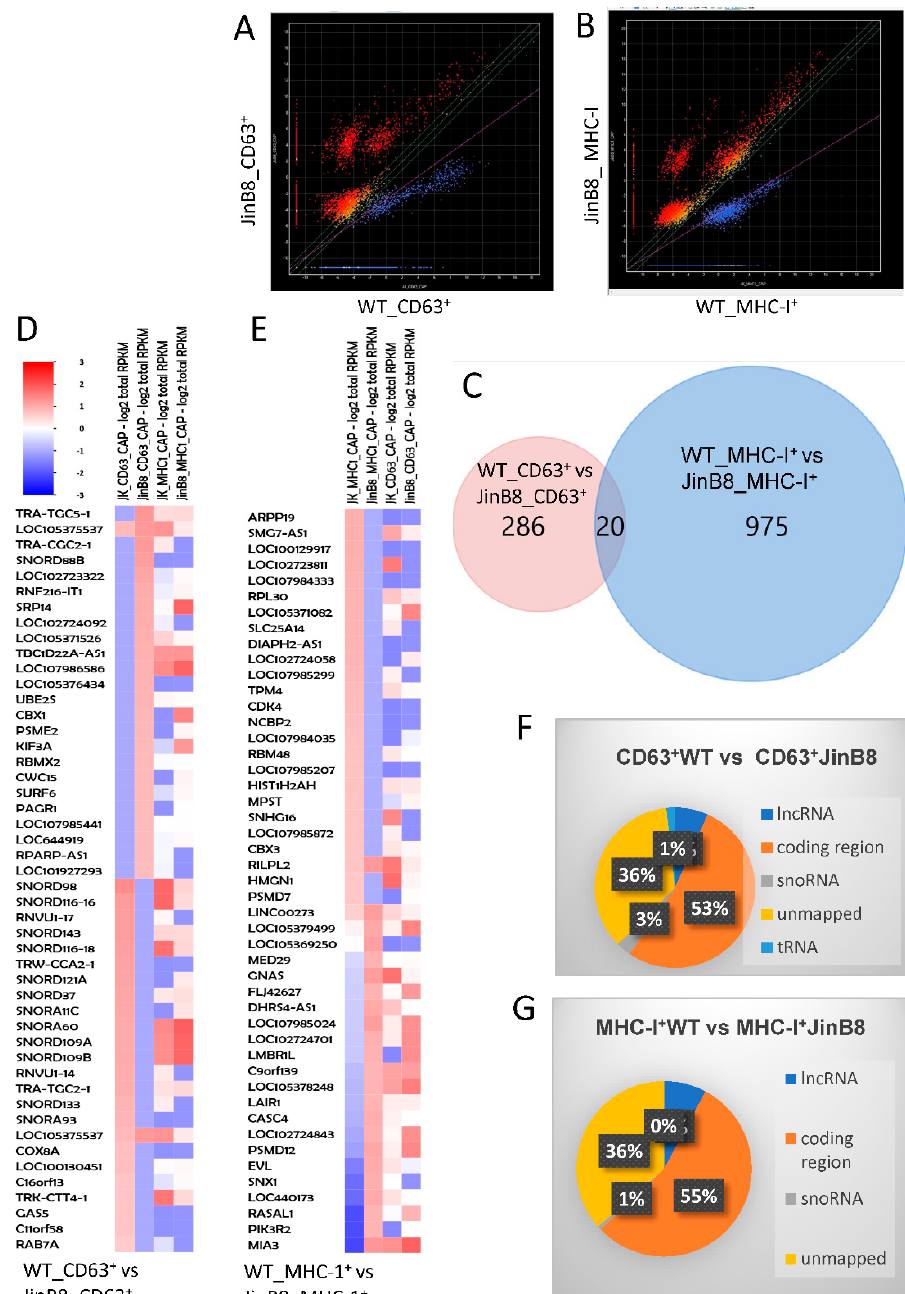
Figure 2. ( A ) Scatter graph showing abundance of RNAs in CD63 + EVs from WT Jurkat vs. JinB8 cells (red or blue = p < 0.05, n = 2, biological replicates). ( B ) Scatter graph showing abundance of RNAs in MHC-I + EVs from WT Jurkat vs. JinB8 cells ( p < 0.05, n = 2, biological replicates). ( C ). Venn diagram comparing 306 CD47-dependent annotated RNA transcripts in CD63 + EVs from WT Jurkat vs. JinB8 cells and 997 MHC-I + EVs from WT Jurkat vs. JinB8 cells. ( D , E ) Heat maps with supervised clustering showing top CD47-dependent annotated RNA transcripts in CD63 + EVs from WT Jurkat vs. JinB8 cells (( D ), p < 0.05) and in MHC-I + EVs from WT Jurkat vs. JinB8 cells (( E ), p < 0.05), respectively. ( F , G ) Pie charts showing classification of 306 CD47-dependent annotated RNA transcripts in CD63 + EVs from WT Jurkat vs. JinB8 cells (( F ), p < 0.05) and 997 CD47-dependent transcripts in MHC-I + EVs from WT Jurkat vs. JinB8 cells (( G ), p < 0.05). Data files related with Figure 1; scatter graph cd63 pval05_Data_s1 and scatter graph cd63